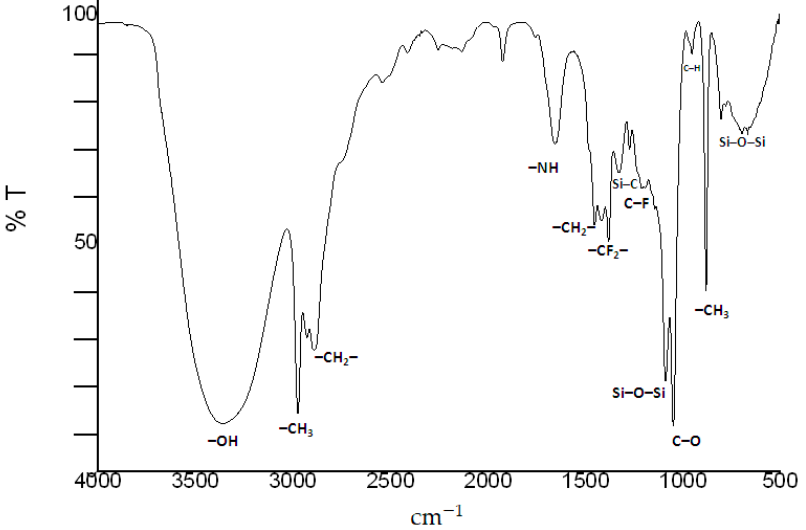
Figure 1. Spectrum of TEOS-FAS sol. Table 1. Static contact angle (CA) and sliding angle (SA) of water drops on various coated substrates. The coating method and TEOS-FAS uptake after drying are reported.